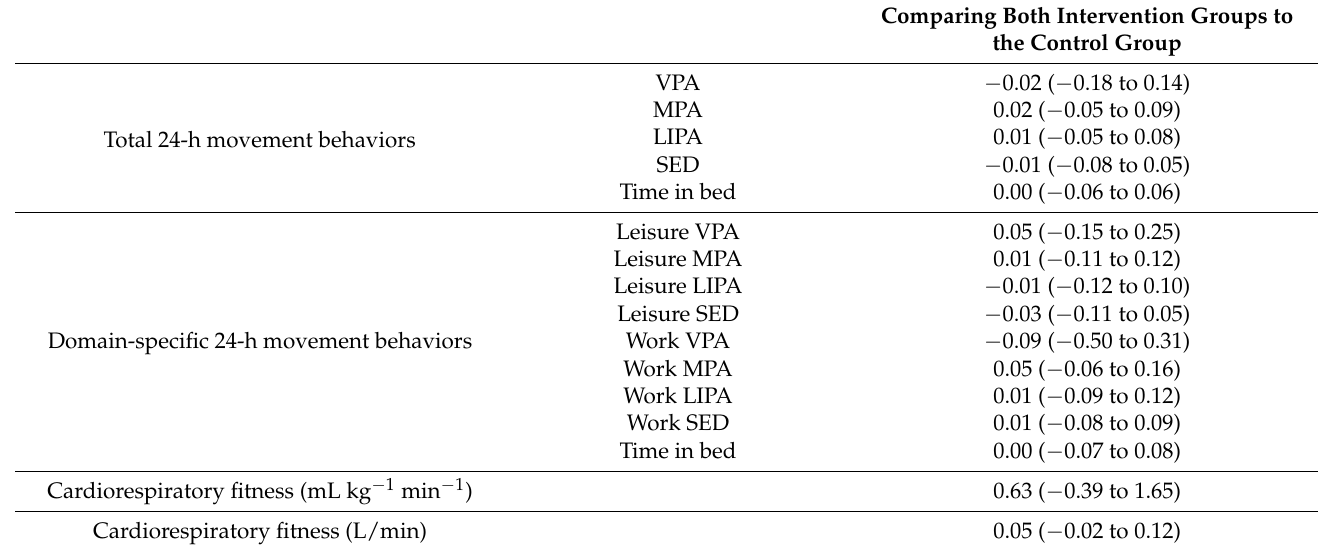
Table 6. Differences in change from baseline to follow-up between groups for total movement behaviors, domain-specific movement behaviors and cardiorespiratory fitness (estimates with 95% CI), based on the linear mixed models.